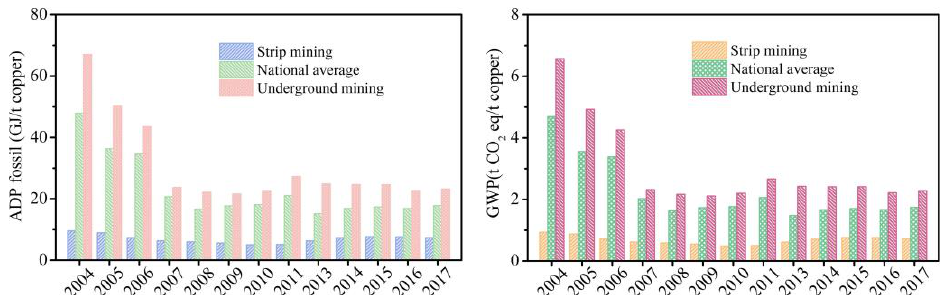
Figure 9. Environmental indicators of the strip mining and underground mining.